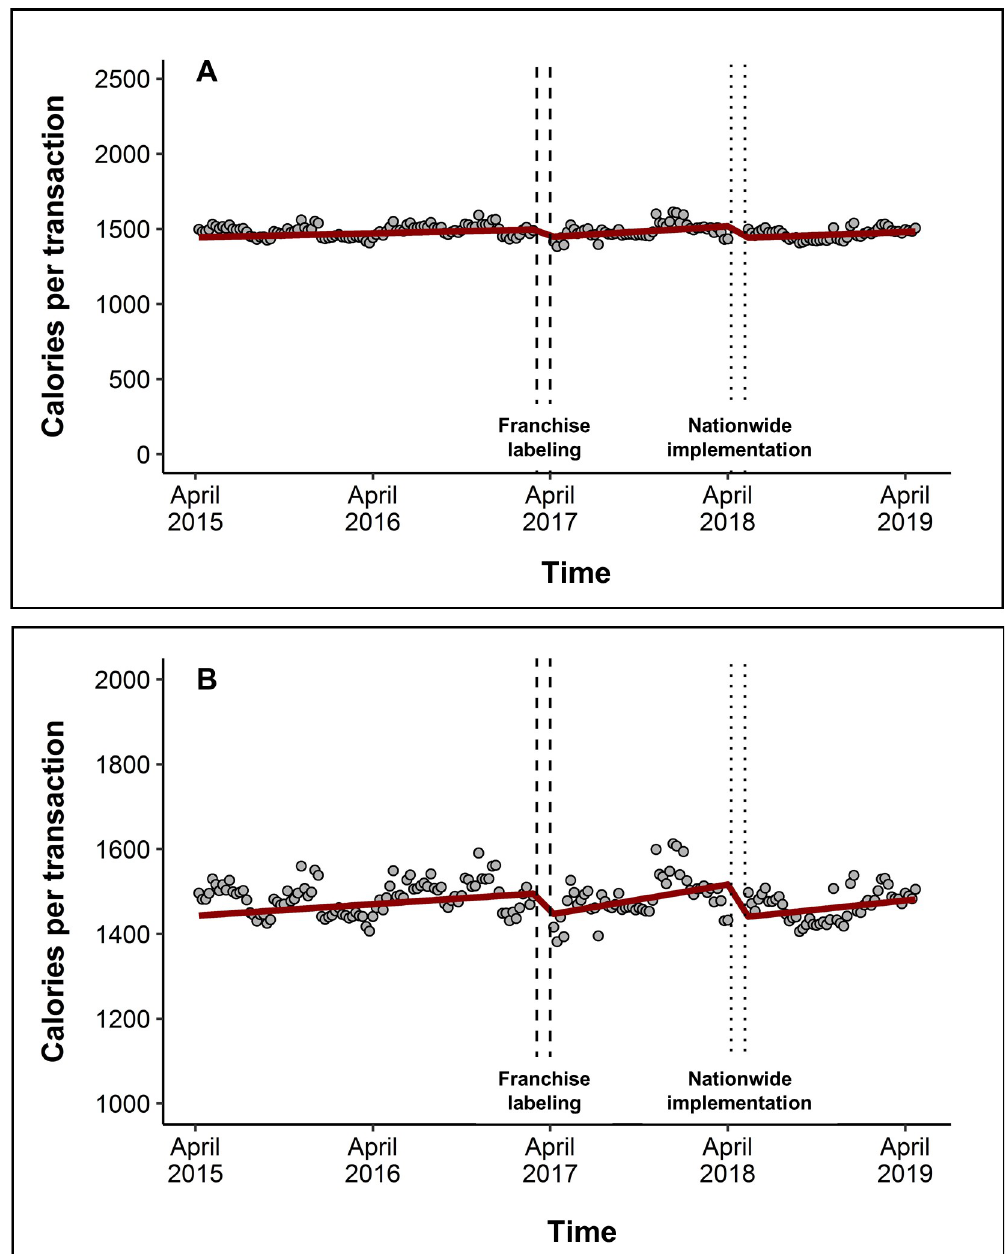
Fig 1. Level and trend changes in mean purchased calories per transaction after franchise labeling and implementation of labeling nationwide. (A) The graph shows mean calories/transaction across all restaurants (gray dots) and the predicted calories/transaction from the model (red line). The model is also adjusted for seasons and holidays, but these effects are not depicted here. The time surrounding franchise labeling (April 2017) is depicted as dashed vertical lines, and the time surrounding nationwide implementation (May 2018) is depicted as dotted lines. (B) Same as (A) but magnified to see level and trend changes more easily.